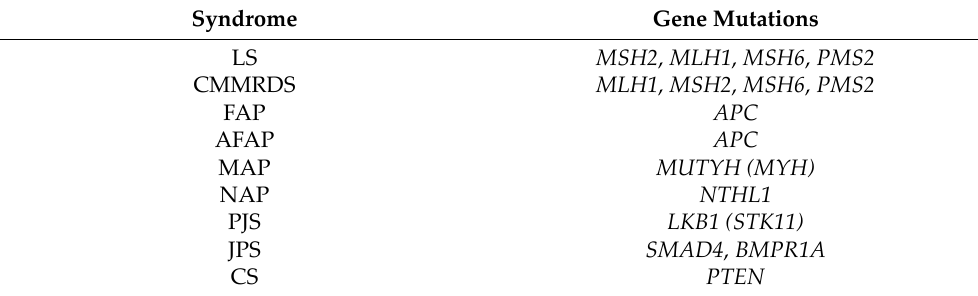
Table 1. Mutations in genes responsible for the described syndromes’ development [31,70,99,117, 122,137,158,175].